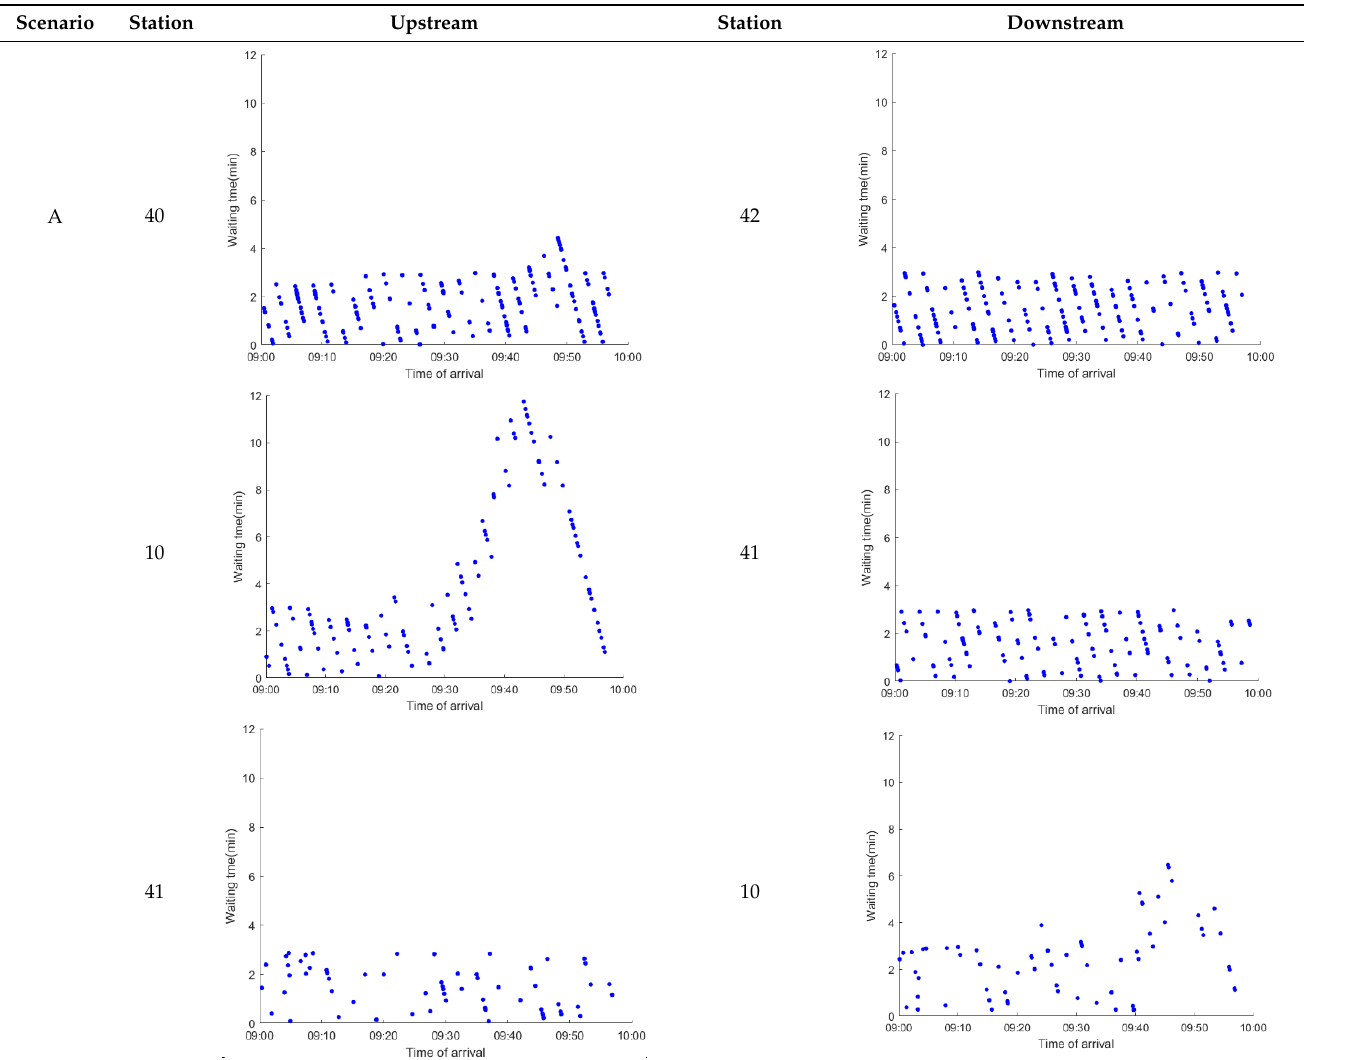
Table 11. Distribution of waiting time per bus passenger in Scenario A.